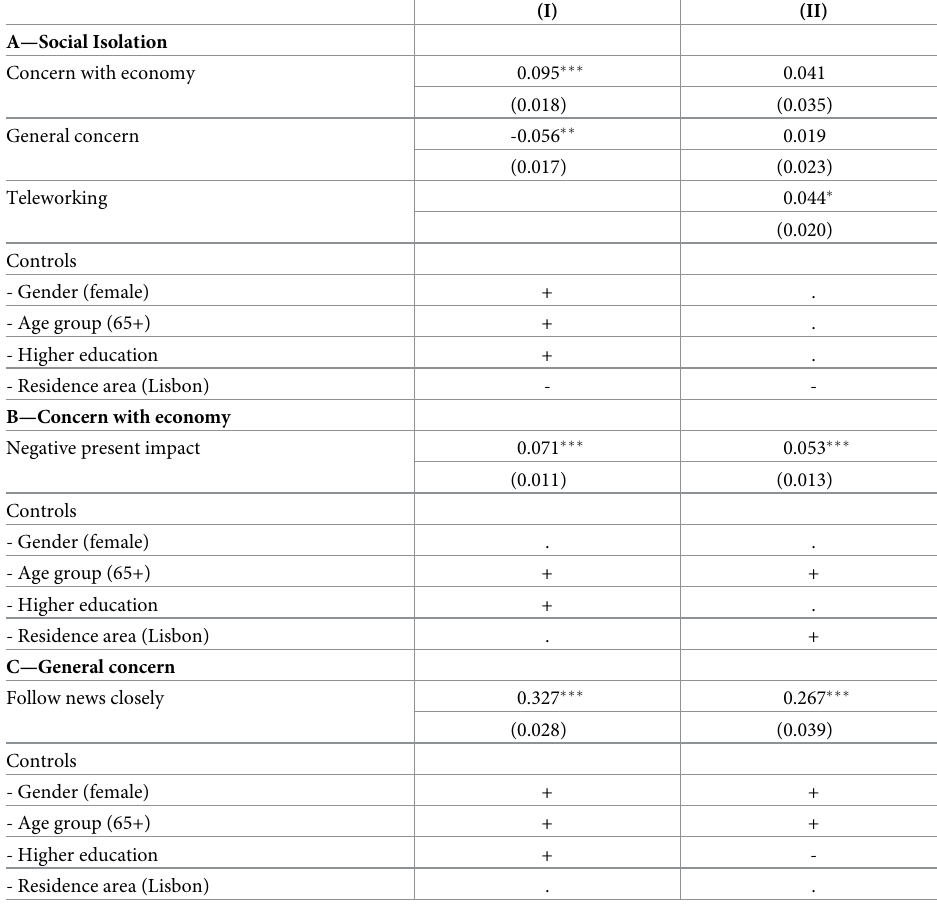
Table 5. SEM results for social isolation, concerns and